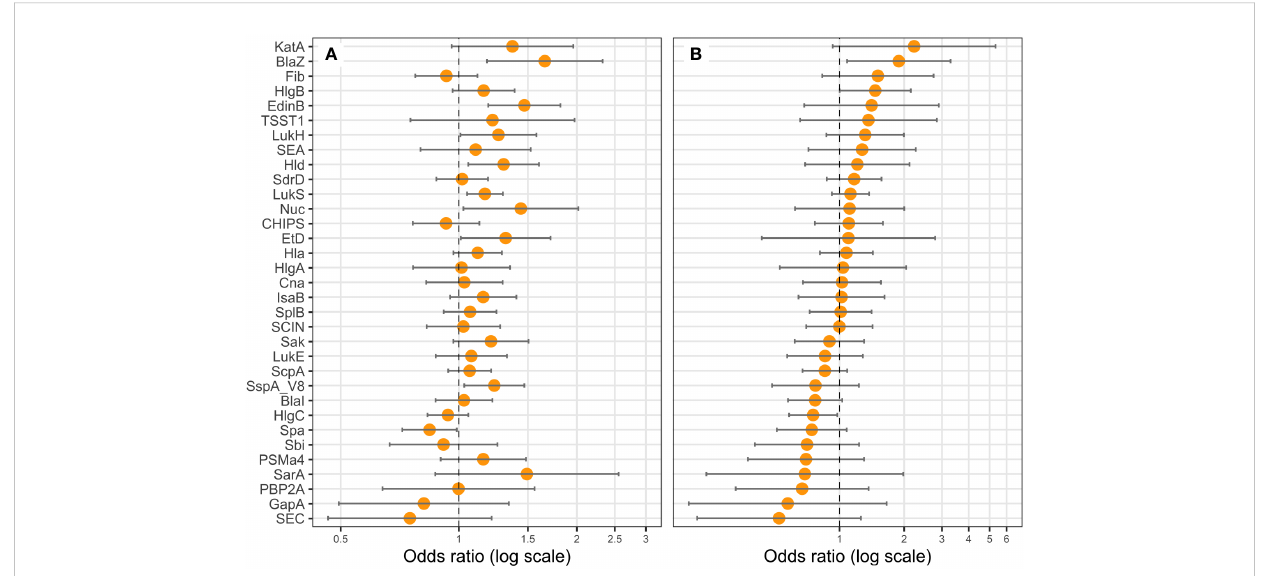
FIGURE 5 BlaZ, HlgB, and HlgC expressions are correlated with hemoptysis. Logistic regression models including the Charlson Comorbidity Index score as covariate were performed, with either the expression level of (A) one protein (univariate), or (B) all proteins (multivariate) as explicative variables, and hemoptysis as the response variable. Coef fi cients were reported as odds ratios (orange dots) with 95% con fi dence intervals (error bars). LukF-PV from LukSF-PV, LukG from LukGH, PSM a 1 from PSM a 1-4, and LukD from LukDE were removed from the statistical analysis to account for